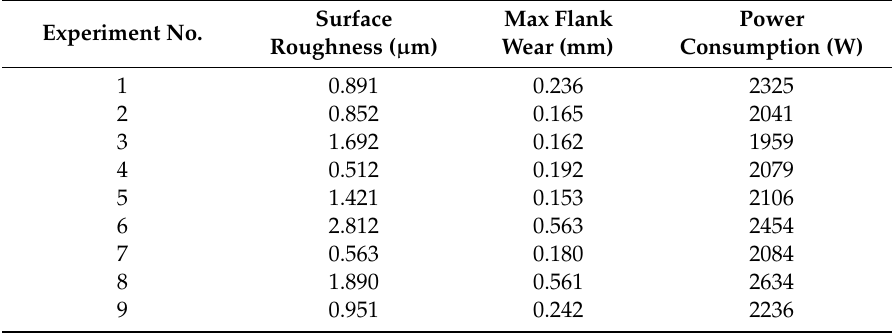
Table 2. Experimental